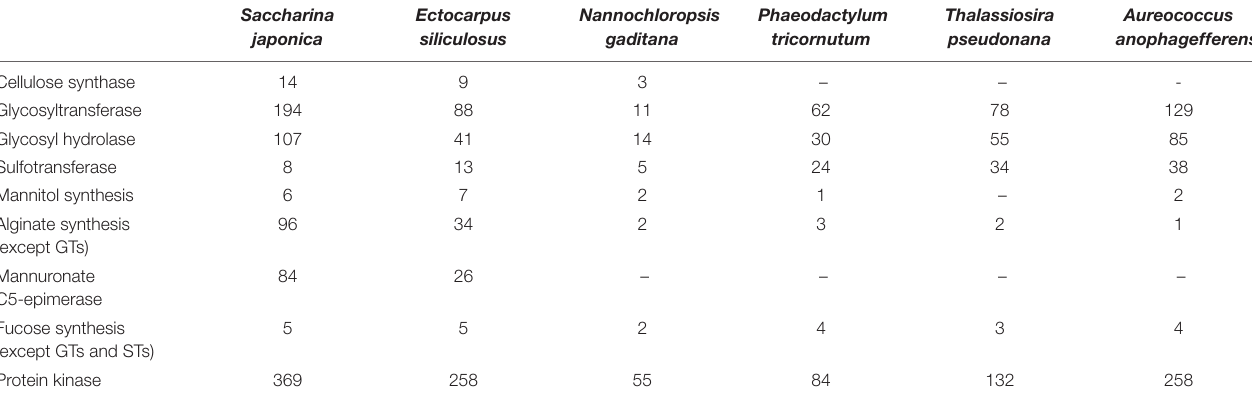
FIGURE 2 | Phylogenetic tree topologies of housekeeping genes using MrBayes software. (A) EF1 α , (B) GAPDH, (C) Actin, (D) TUA, and (E) TUB. ChlP, Chlorophyta; Rho, Rhodophyta; Fun, Fungi; Pha, Phaeophyceae; Dia, Diatom; Oom, Oomycetes; Cya, Cyanobacteria; Bac, Bacteria; Arc, Archaea; Hap, Haptophyta; Cry, Cryptophyta; Gla, Glaucophyta. TABLE 3 | Gene number of different metabolisms and gene families in sequenced Heterokontophyta